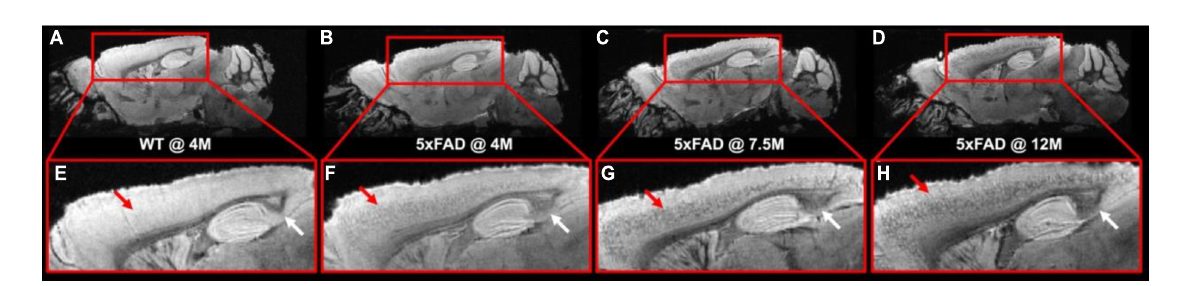
FIGURE1 The T2*-weighted images of WT mice (A,E) at 4 months and 5xFAD at different ages (4, 7.5, and 12 months, B–D , F–H ). Numerous dark spots were clearly evident in the cortex and hippocampus regions of the 5xFAD mice.